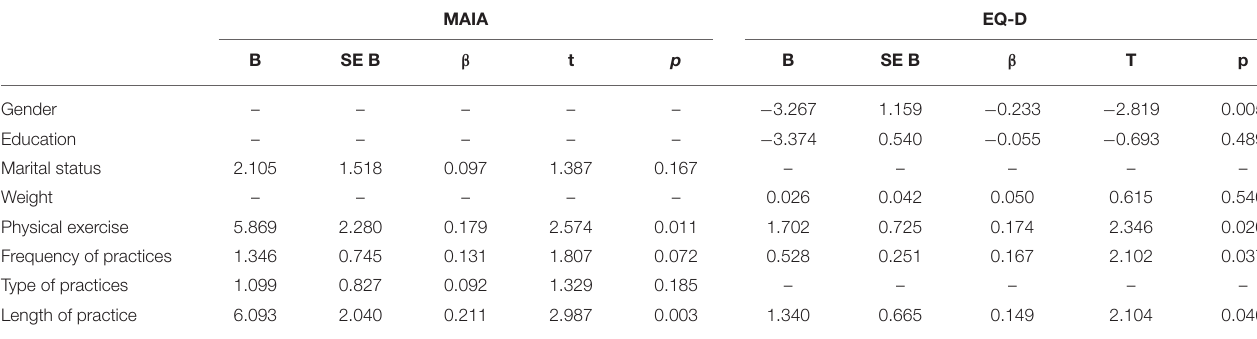
TABLE 3 | Hierarchical regression analysis with perseverance in yoga as the predictor variable in total Multidimensional Assessment of Interoceptive Awareness (MAIA) and Experiences Questionnaire-Decentering (EQ-D) total scores after controlling sociodemographic characteristics, life habits, and aspects of yoga practice. MAIA